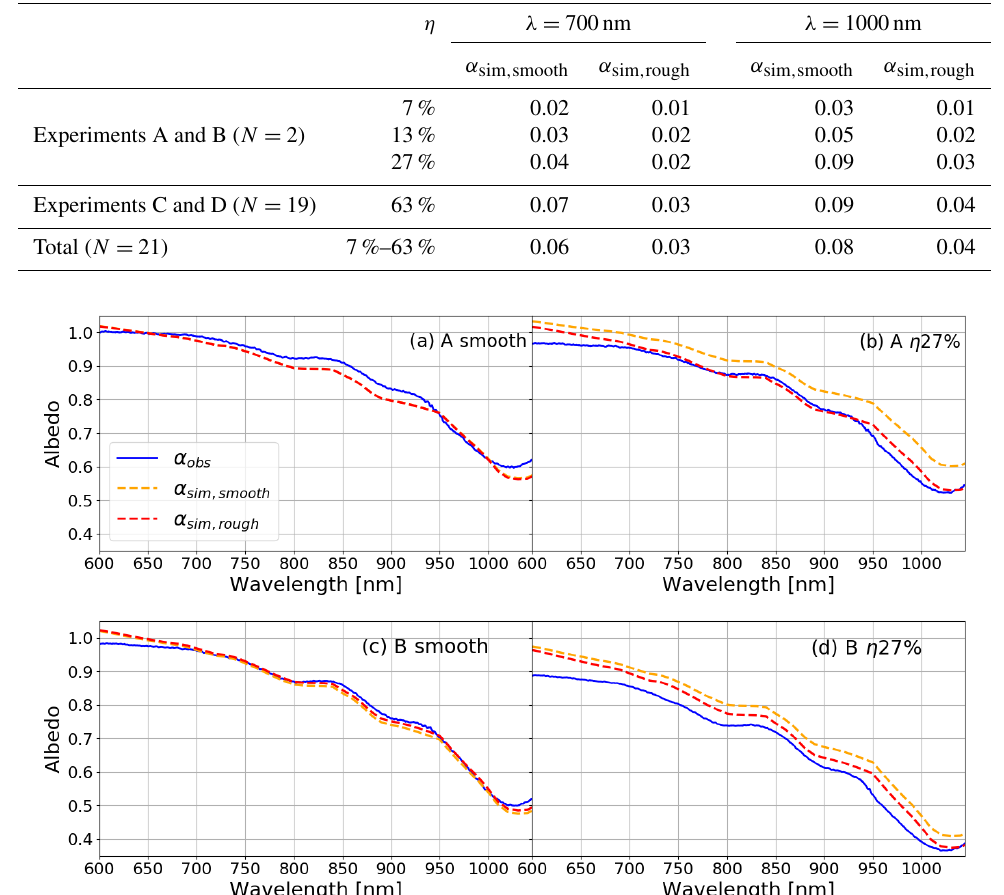
Table 3. The RMSD of α sim , smooth and α sim , rough at 700 and 1000nm. The RMSD is calculated with Eq. (16). N is the number of studied surfaces. For experiments C and D, RMSDs are calculated for the simulations over the rough surface.